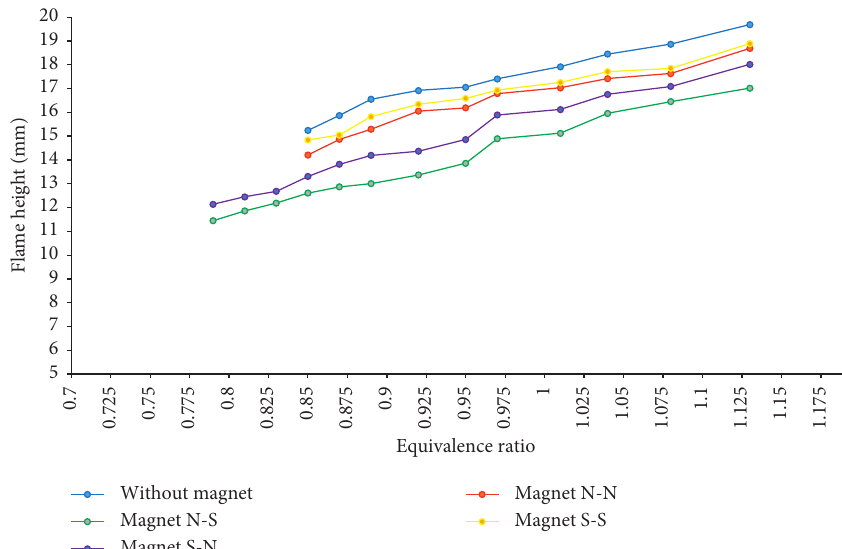
Figure 11: Flame height of jatropha oil versus equivalence ratio at various magnetic field orientation and without magnetic field.